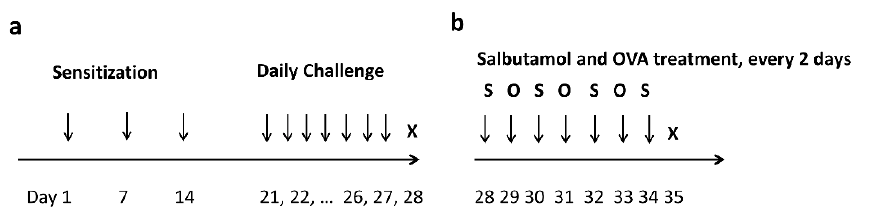
Figure 7. Protocol for the induction of AAD and salbutamol treatment in mice. ( a ) The timeline illustrates that mice were intraperitoneally injected with OVA, alum, or saline and subsequently intranasally administered saline or OVA from days 21 to 27. Mice were sacrificed on day 28. ( b ) After completion of the nasal OVA challenge, mice from the salbutamol group were treated with salbutamol. Mice were intranasally challenged with salbutamol and OVA every alternate day from days 28 to 34. Mice were sacrificed on day 35.